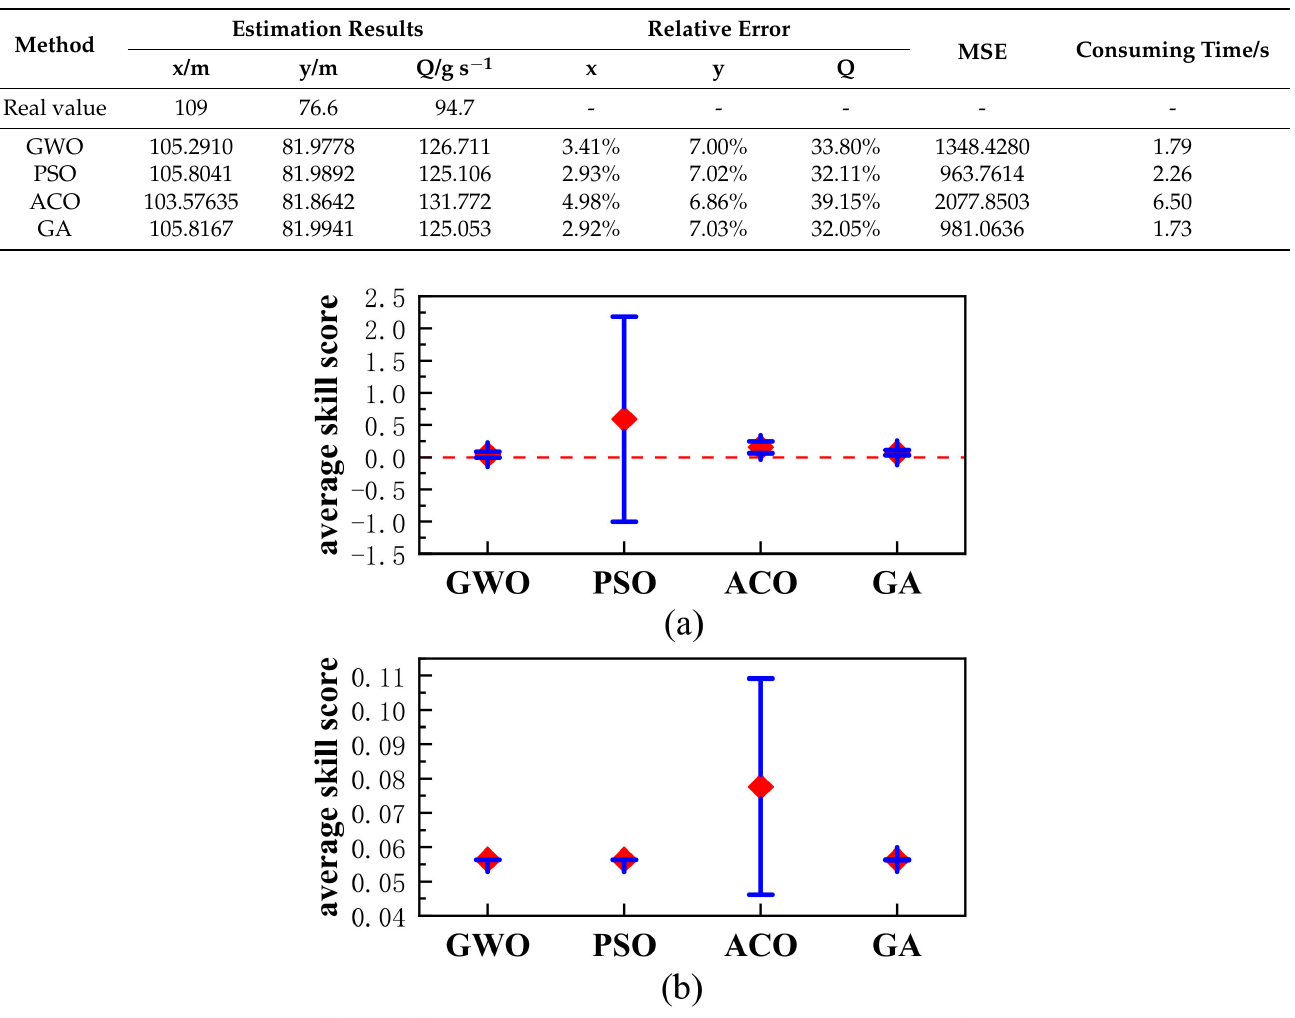
Table 3. Source estimation results of different methods for run 33.